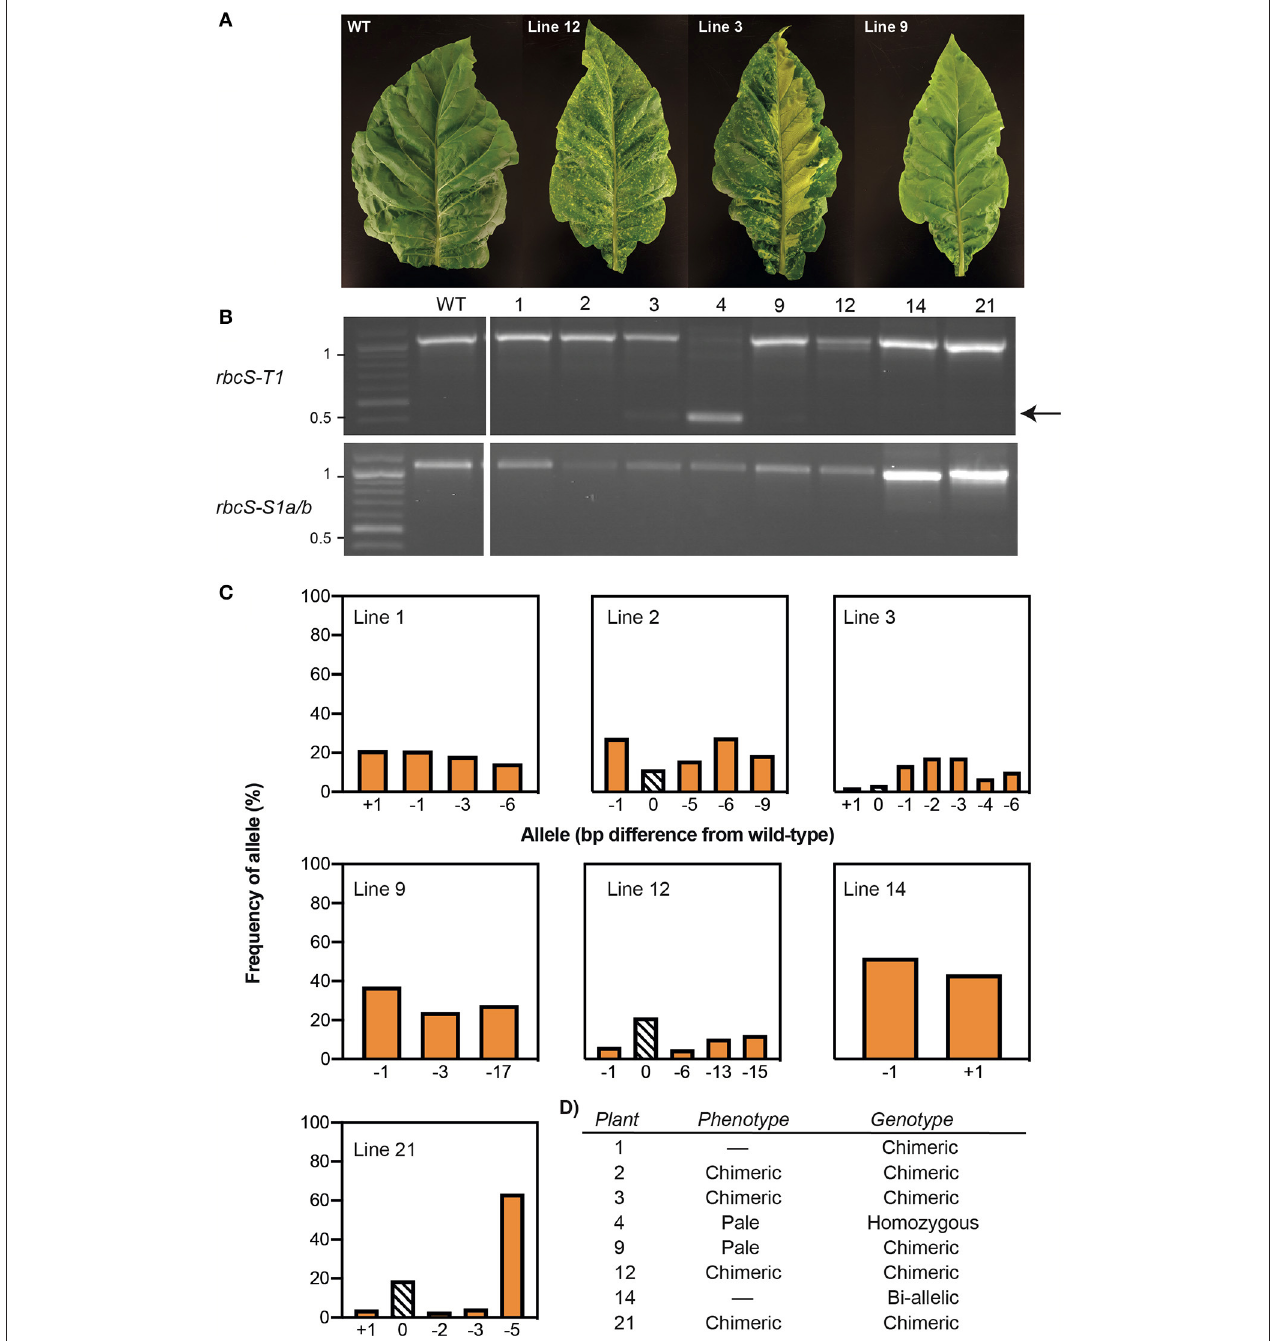
FIGURE 2 | Phenotypes and genotypes of tobacco plants transformed with Cas9-gRNA vector pGRNA14. (A) T 0 plants had paler leaves than wild-type (WT) (e.g., line 9) or chimeric leaf phenotypes (e.g., lines 3 and 12). (B) A PCR screen of rbcS-T1 and rbcS-S1a/b in eight T 0 lines identified a deletion between gRNA1 and gRNA4 in rbcS-T1 in line 4 (arrow) and wild-type-sized amplicons for the remaining plants. (C) TIDE analysis of the sequencing chromatograms for wild-type-sized amplicons of rbcS-T1 showed the frequency of wild-type (0 bp) or mutant [insertion ( + N bp) or deletion –N bp)] alleles. (D) Summary of phenotypes and rbcS-T1 genotypes of T 0